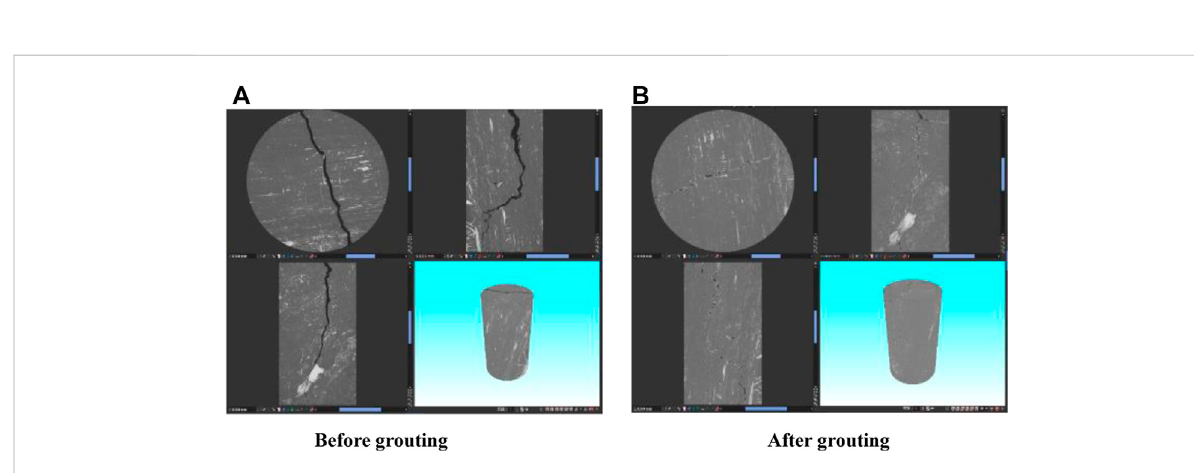
FIGURE 5 CT scan of coal sample before and after grouting. (A) Before grouting. (B) After